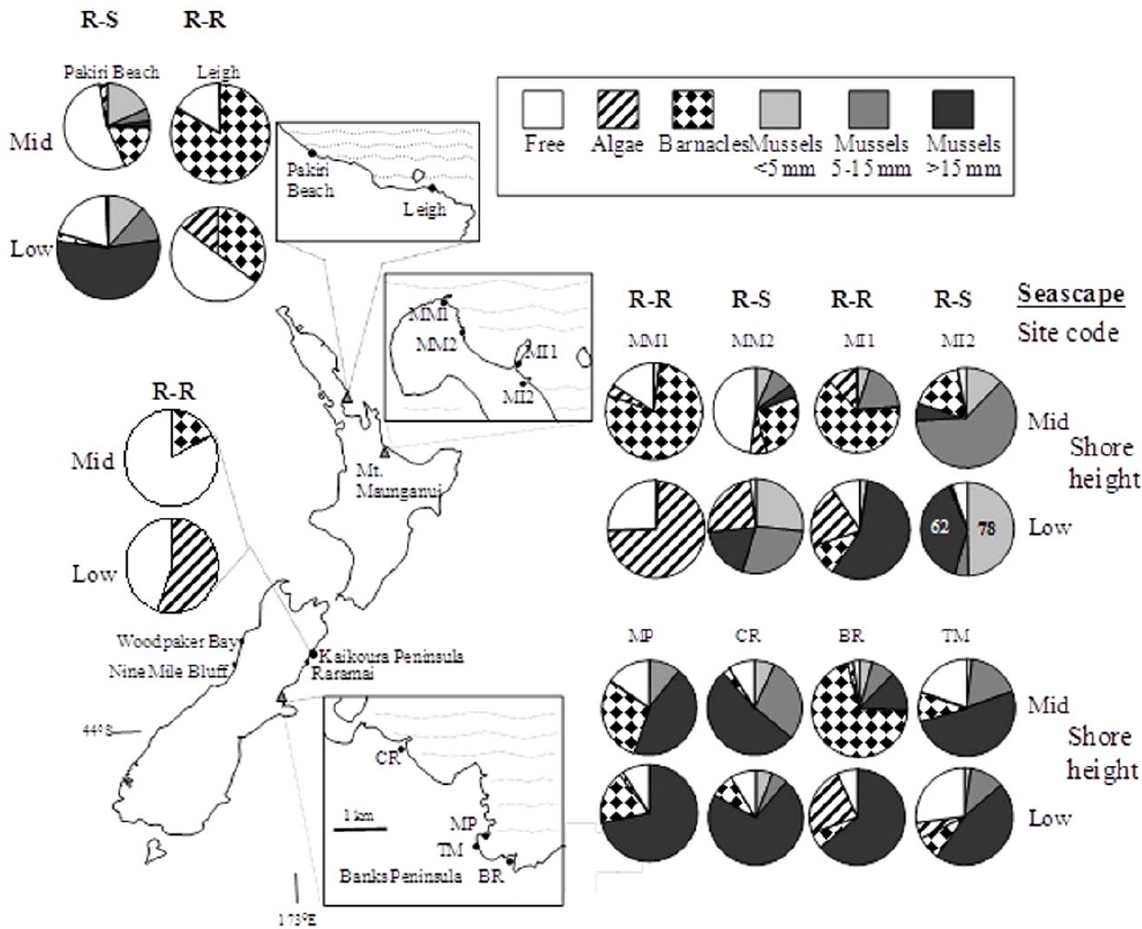
Figure 1. Study sites and percent rock cover of major space occupiers in the mid and low shore levels at R-R and R-S seascapes in New Zealand. Space occupiers include mussels of different size classes, macroalgae, barnacles and free space. CR is located about 1 km west of the nearest extensive rocky shore. TM is located 190 m from the western rocky side of a small sandy bay. MM2 is a small isolated bench located about 40 m from the rocky shore that surrounds the mount. MI2 is a rocky bench 200 m east of the Moturiki Island (see text). Pakiri is a R-S site which is at the beginning of a rocky shore at the end of the sandy Pakiri Beach. At the MI2 low shore, total cover exceeded 100% (because many mussel recruits covered adults) and actual percent cover for those groups is given in numbers on the pie chart. The Kaikoura Peninsula site was sampled in January 2004, Banks Peninsula sites in April 2004, Mt Maunganui sites in June 2004 and the Leigh sites in September 2004. A subset of this data appeared in Rilov and Schiel